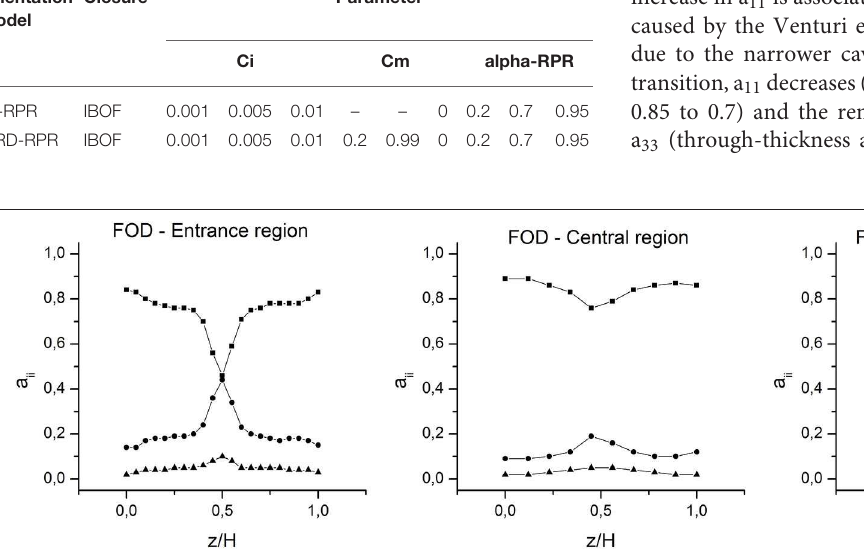
Frontiers in Materials |